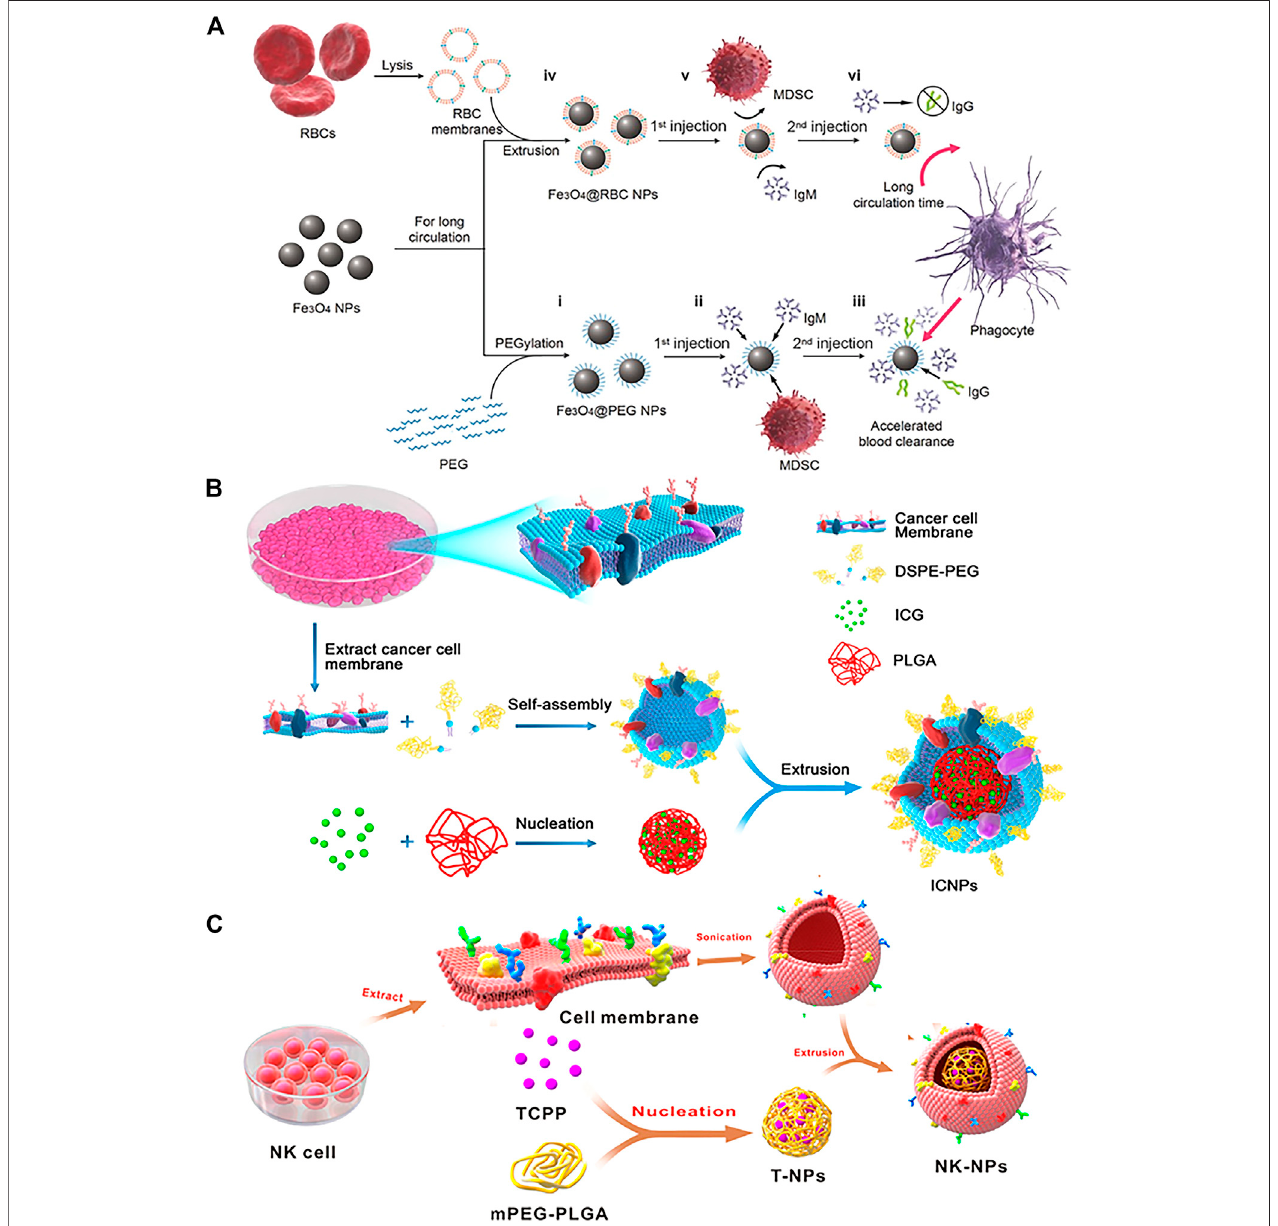
FIGURE1|(A) SchematicofpreparationsofFe 3 O 4 @PEGandFe 3 O 4 @RBCNPsandtheeventsaftertheyareinjectedintotheblood(Reproducedwithpermission from Rao et al. (2015)). (B) The schematic preparation procedure of ICNPs. Fusing cancer MCF-7 cell membrane and PEGylated phospholipids (DSPE-PEG) and then coatingontoICG-loadedpolymericcoresbyextrusion.(ReproducedwithpermissionfromChenetal.(2016)). (C) SchematicIllustrationofNKCell-Membranes-Cloaked Nanoparticles(NK-NPs) (Reproduced with permission from Deng G. et al. (2018)).